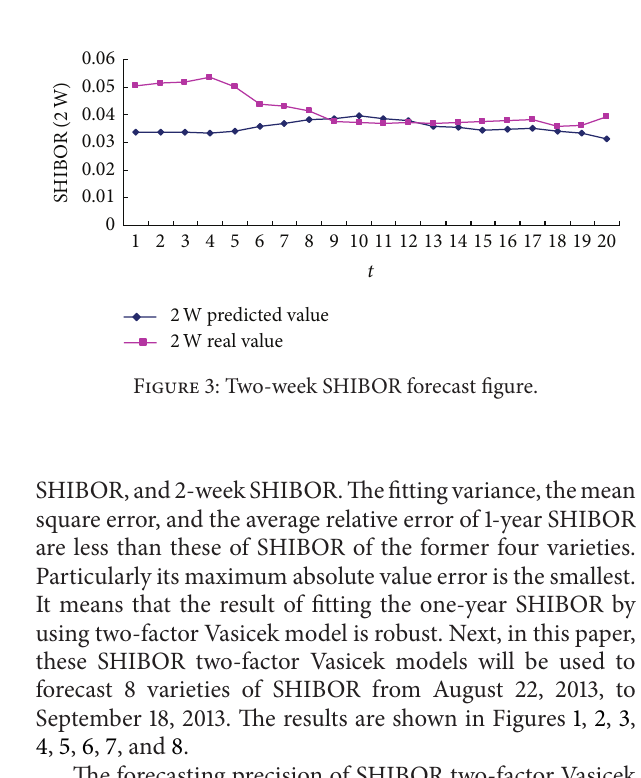
Figure 1: Overnight SHIBOR forecast figure. Figure 2: One-week SHIBOR forecast figure.